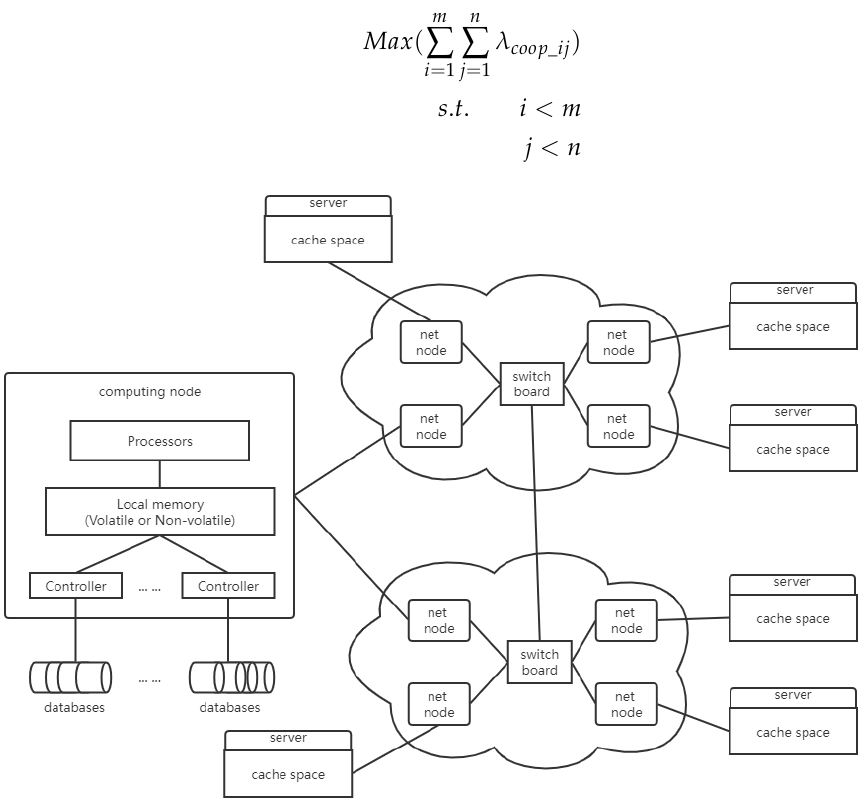
Figure 3. The network architecture of remote cache